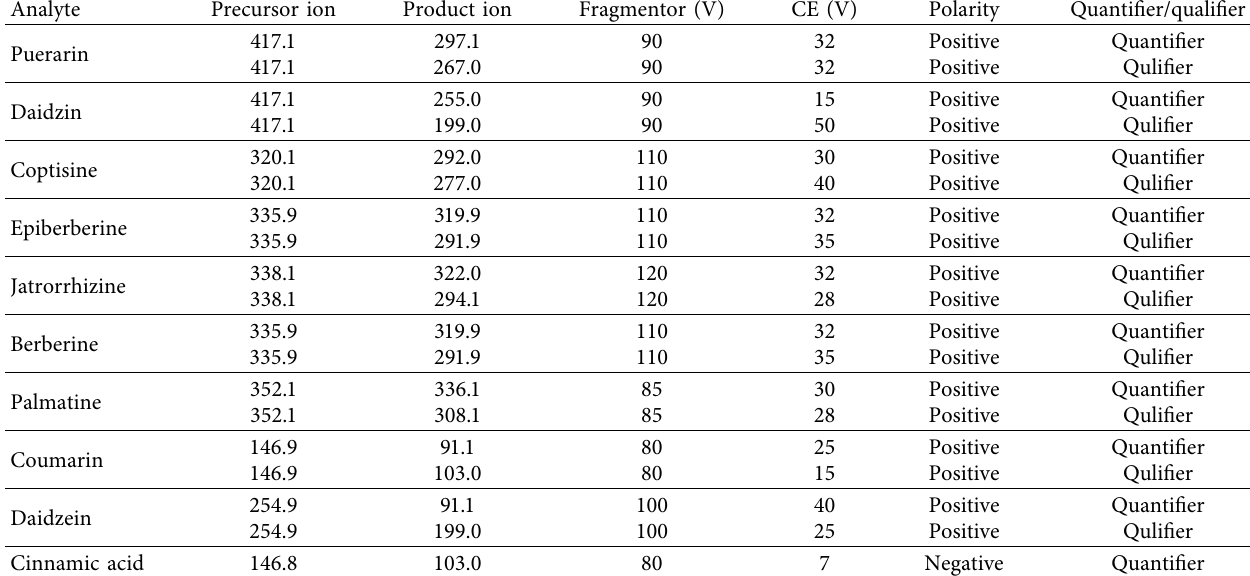
Table 1: Analytical MRM parameters of the developed UHPLC-QQQ-MS method.